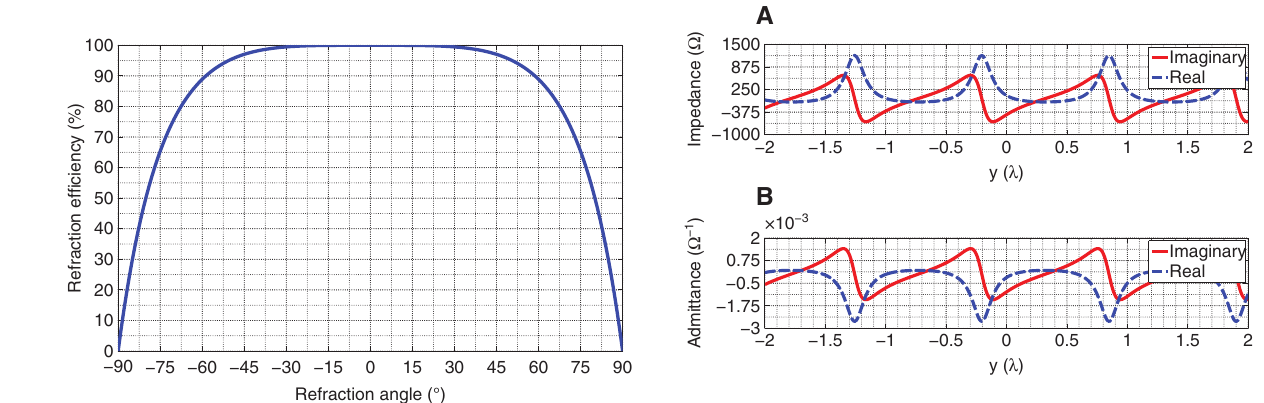
Figure 5: Refraction efficiency as a function of the refraction angle with normally incident plane wave for a non-bianisotropic HMS. Obtained from Ref. [41].